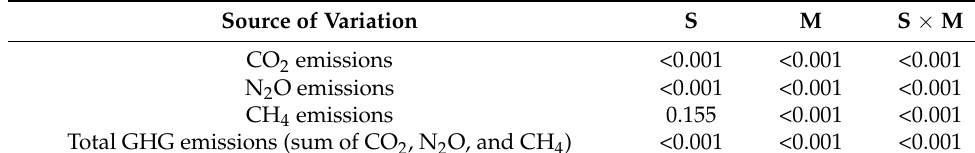
Table 2. Results of two-way ANOVAs ( p -values) testing the effects of manure type (M), soil type (S), and their interactions (S x M) on cumulative greenhouse gas (GHG) emissions ( n = 4). Source of Variation